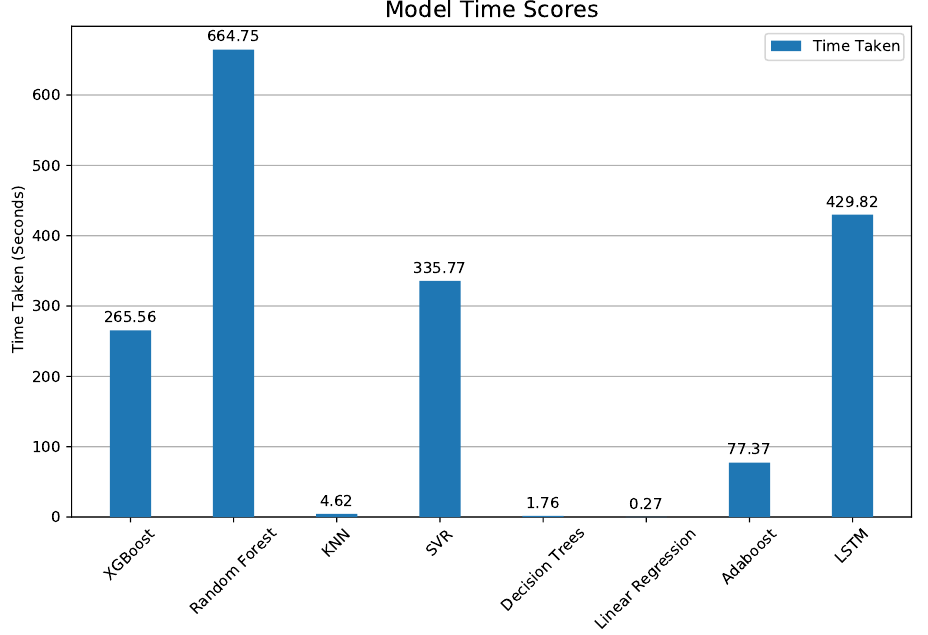
Figure 12. Time taken for each model for one year of hourly predictions, including training.